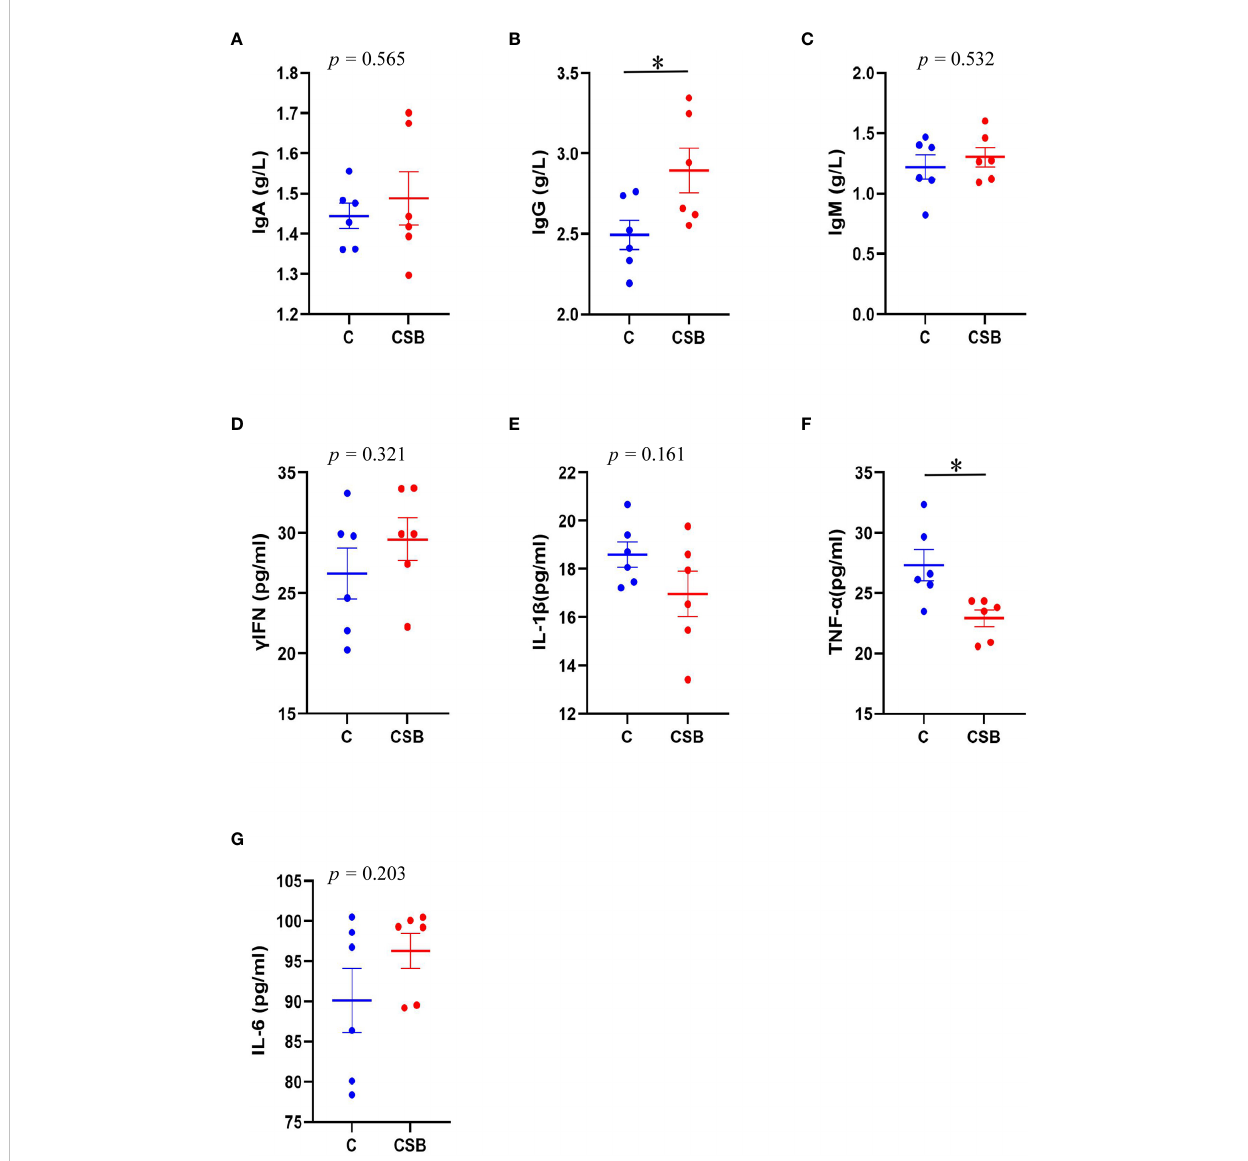
FIGURE 3 Effects of dietary supplementation of coated sodium butyrate (CSB) on the serum immunoglobulin (Ig) and in fl ammatory cytokine levels of laying ducks. (A) IgA. (B) IgG. (C) IgM. (D) Interferon (IFN)- g . (E) Interleukin (IL)-B. (F) Tumor necrosis factor (TNF)- a . (G) Interleukin (IL)-6. Values are presented as means ± SEM (n = 6). * p< 0.05. group C, Control group, which was fed a basal diet; CSB group, CSB-treated group, which was fed the basal diet supplemented with 250 g/t of